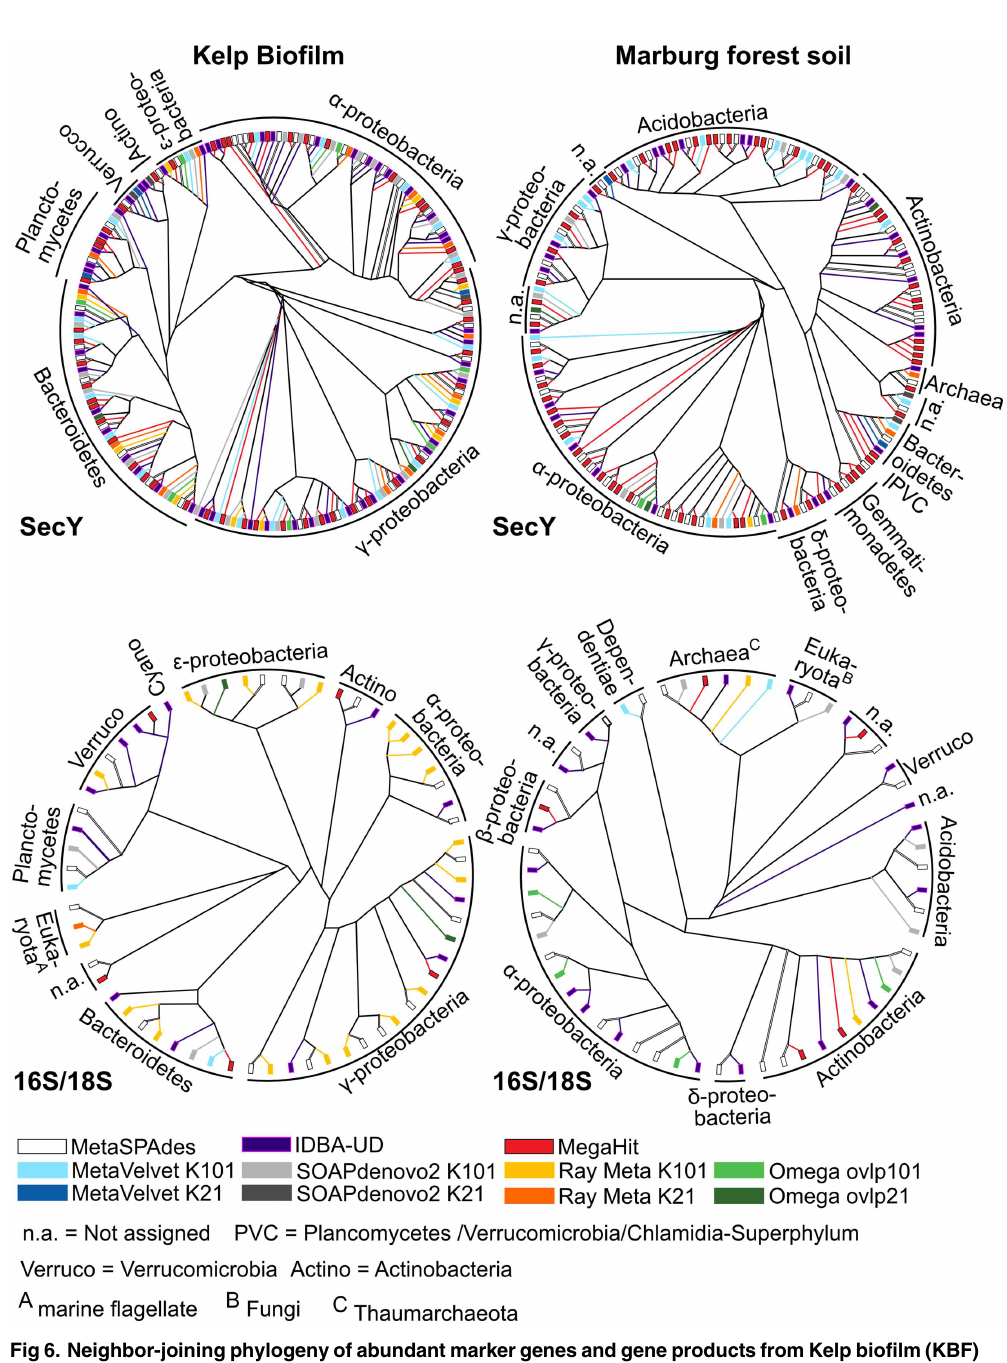
Fig 6. Neighbor-joining phylogeny of abundant markergenes and gene products from Kelp biofilm (KBF) and Marburg forest soil (MFS) samples. Phylogeniesare displayedas cladograms, since they providea more orderedand less-crowded overviewthan phylograms. Therefore, clustering is shown correctly but terminal branch lengthsdo not reflect actual phylogenetic distances. A&B) Gene product COG201, referringto preprotein translocasesubunitSecY. C&D) 16S and 18S rRNA gene sequences.Different coloring of terminal branches indicatemarker sequencesproducedby different assemblersaccordingto the color code below the cladogram. Taxonomicclassificationsare indicatedfor each observed